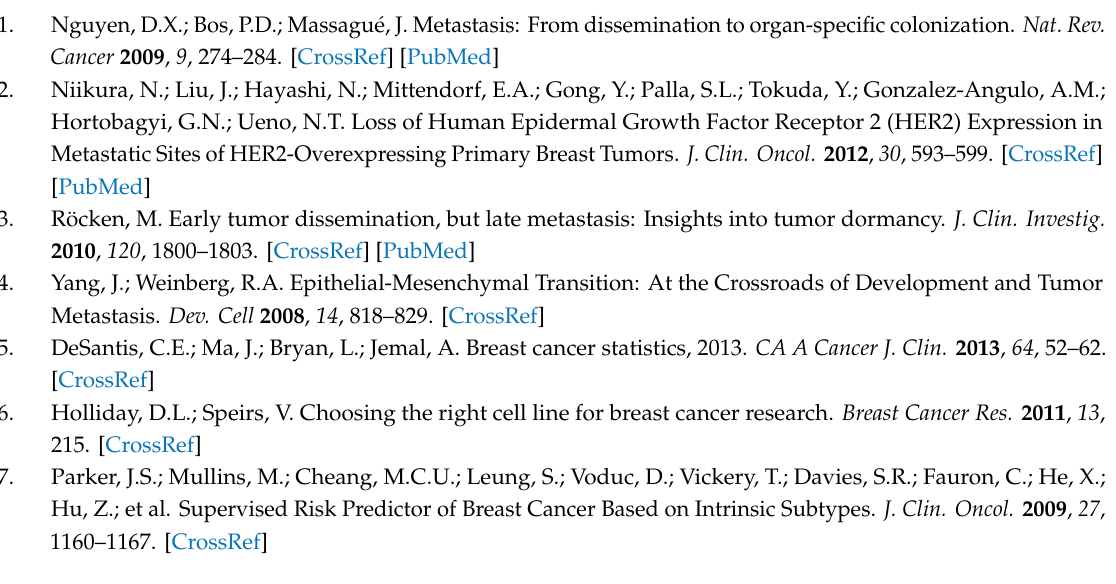
Table S1, Test conditions to evaluate the metastasis of Ca1a cells, Table S2, Summary of cell tracking parameters, Figure S1, Uncropped immunoblotting of the Ca1a cells, with molecular weight markers and densitometry readings, Figure S2, Number of cells counted from the published cell migration images using our cell tracking algorithm, Mosaic ImageJ plugin, and manual counting, and Figure S3, Ca1a and Ca1h cells in mono-culture and co-culture within µ -Slide Chemotaxis for measuring proliferation, velocity, and